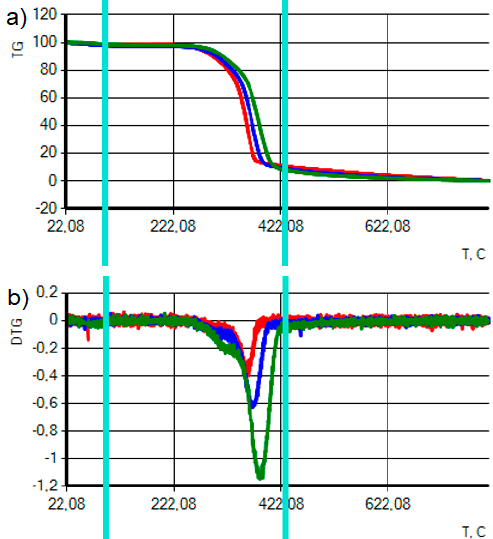
Figure 2. ( a ) Thermogravimetric and ( b ) derivative TG curves of curaua fiber at different heating rates. The heating rates of 10, 20 and 40 °C·min − 1 are represented by the red, blue and green lines. The vertical cyan lines represent the limit of calculation of the kinetic parameters.